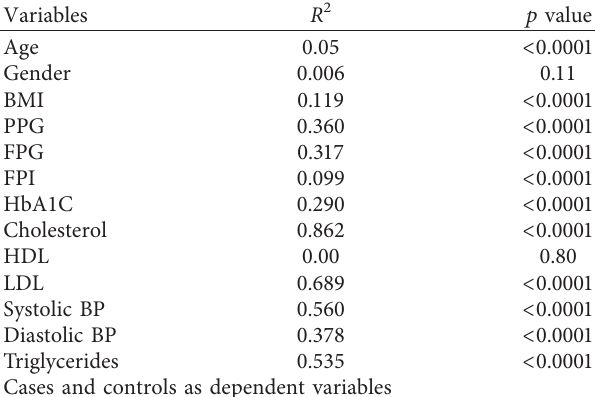
Cases and controls as dependent